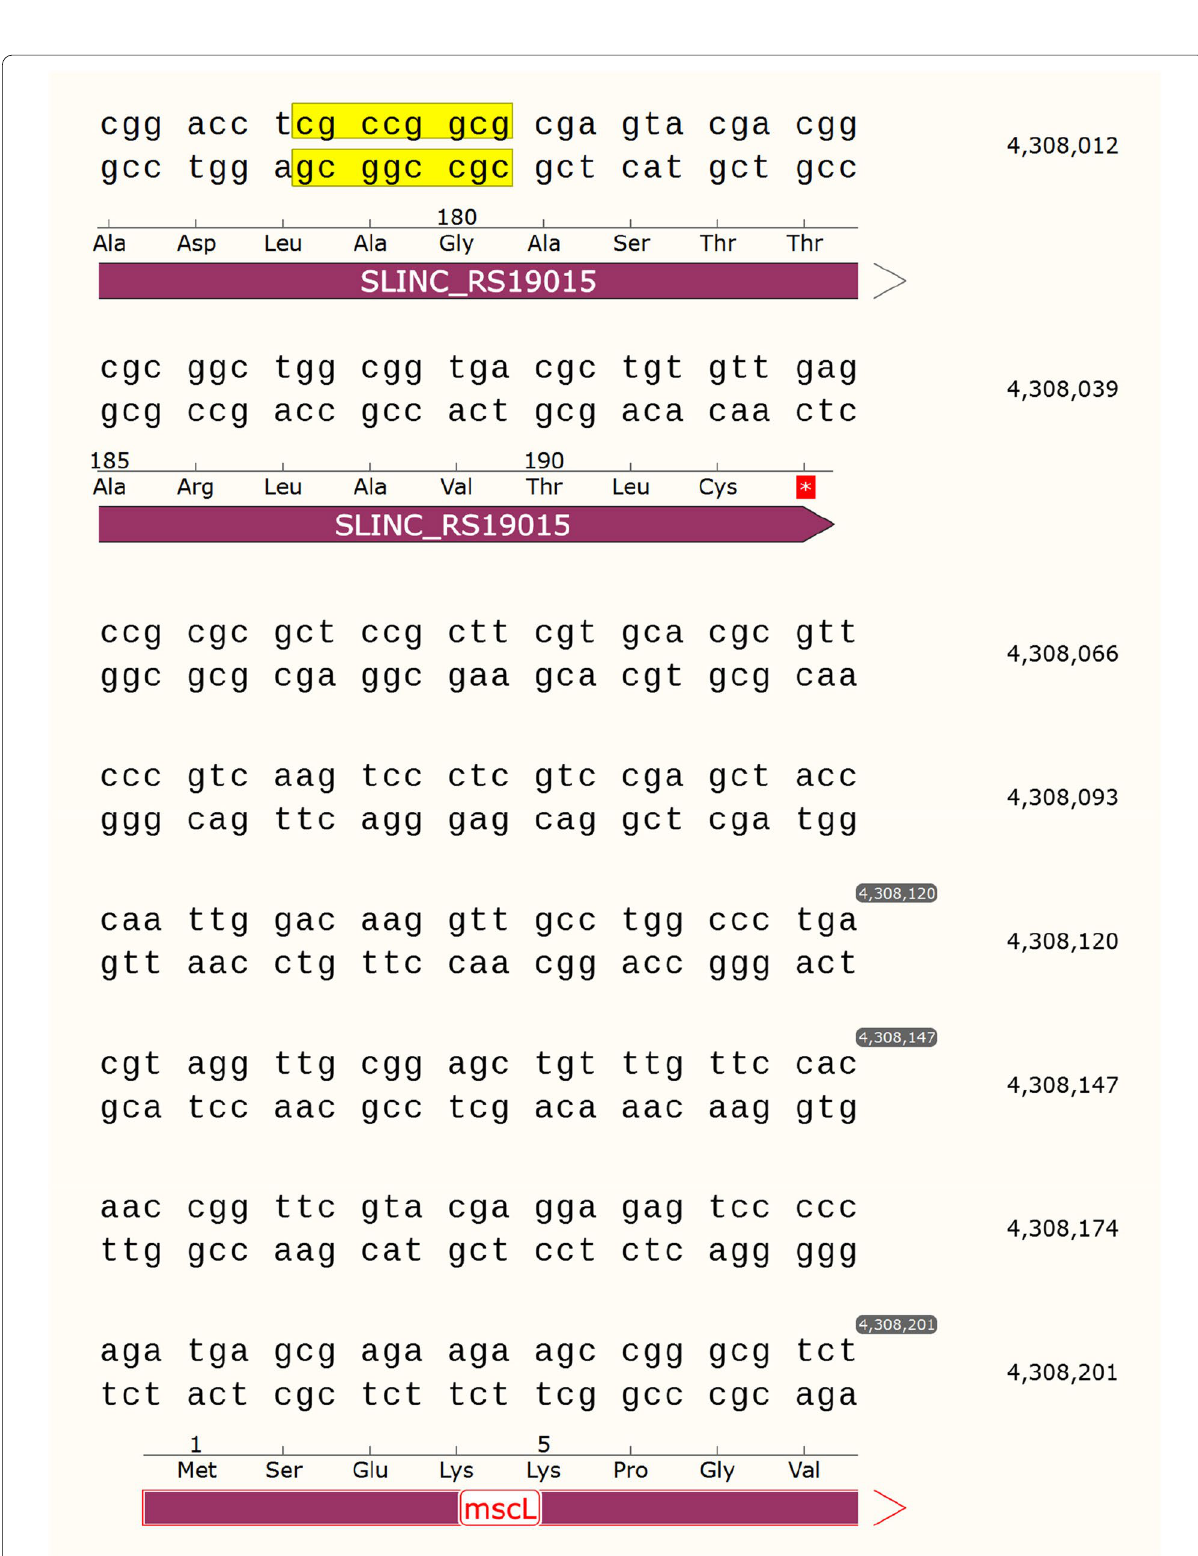
Fig. 6 Nucleotide sequence of the region upstream of mscl and the predicted LmbU binding site